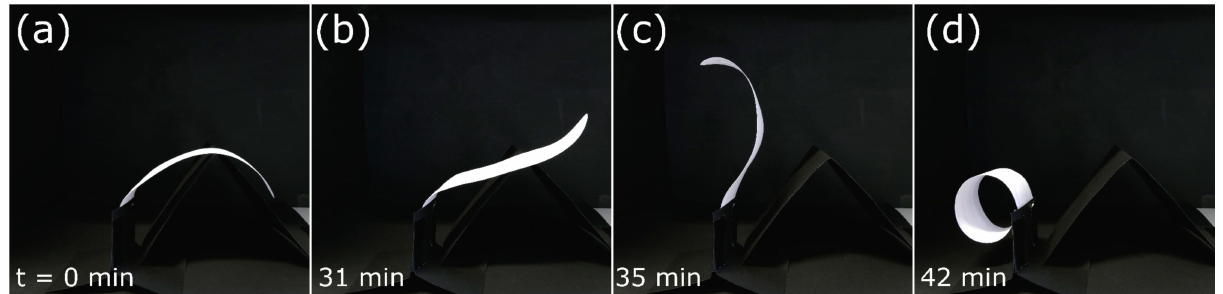
Figure 14. Self-actuated paper-based compliant system inspired by the lily petal ( L. spec.). ( a – d ) Bending sequence during desiccation. Times are indicated bottom